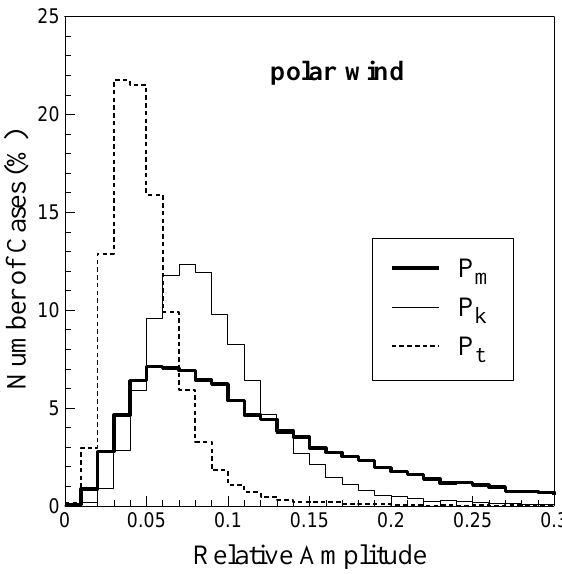
Fig. 9. Frequency distributions of the relative amplitudes for mag- netic ( P m , thick line), thermal ( P k , thin line), and total ( P t , dashed line) pressure fluctuations in polar